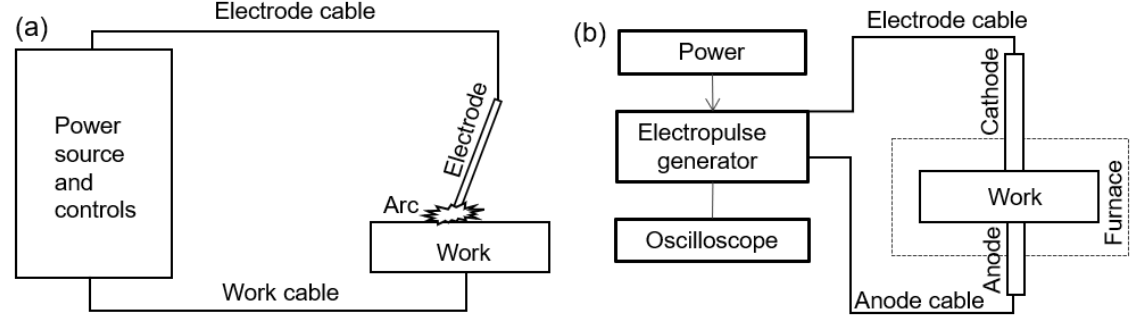
Figure 1. The schematic diagrams of ( a ) electric arc welding and ( b ) the electric effect investigation.